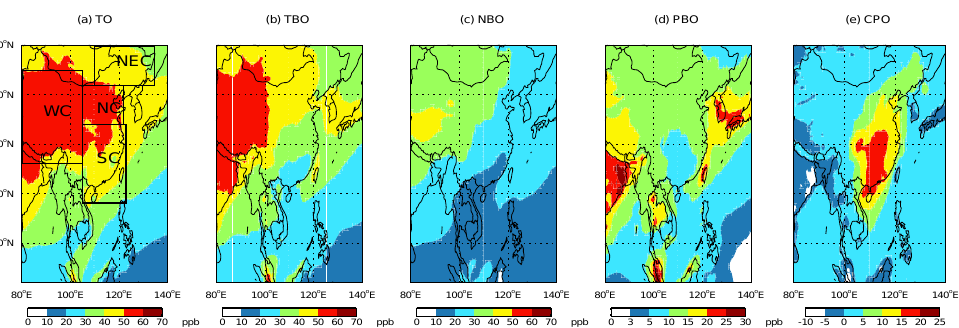
Fig. 5. Annual mean spatial distribution of surface ozone over China. The figure shows the total surface ozone (TO) (a) , total background ozone (TBO) (b) , natural background ozone (NBO) (c) , pollution background ozone (PBO) (d) , and China pollution ozone (CPO) (e) . Note that the color scales for (d) and (e) are different from those of (a–c) . The black lines in (a) show the definition of Chinese regions (WC, NEC, NC, and SC).